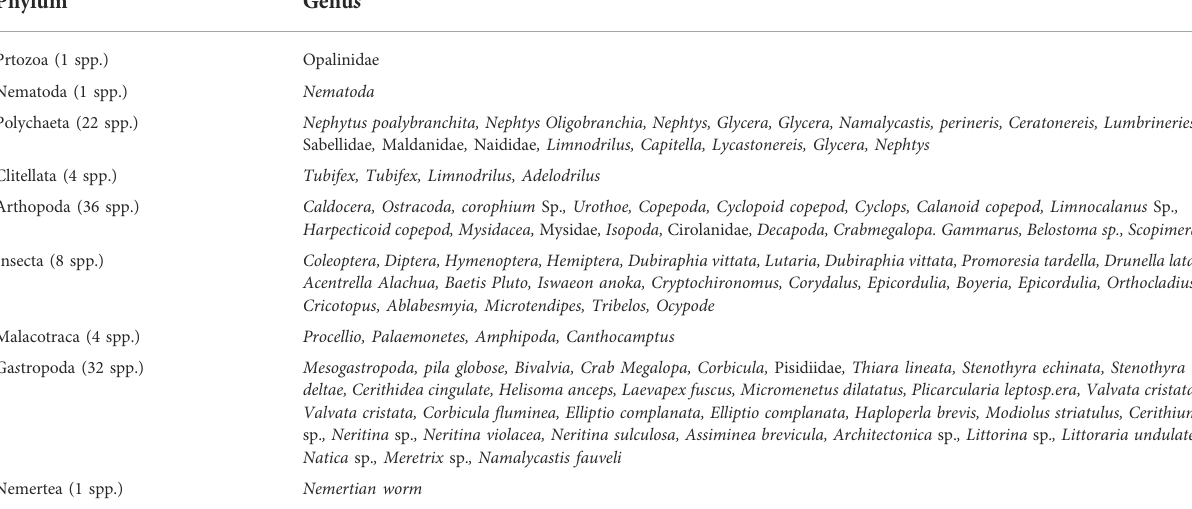
TABLE 7 Diversity of benthos (109 spp.) in the estuarine waters of Bangladesh.